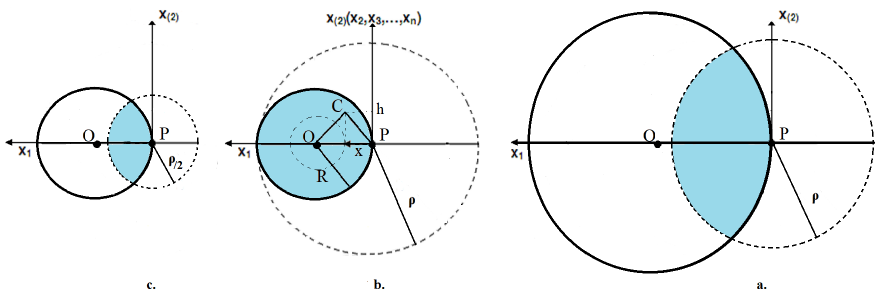
Figure 1. Elitist ES on SPHERE: success region (blue) of uniform mutation. The solid line circle (centered in optimum O) represents the fitness sphere; the dotted circle (centered in current position P) stands for the mutation sphere. As the ES approaches O from sub-figure ( a – c ), mutation radius ρ is halved under the 1/5 success